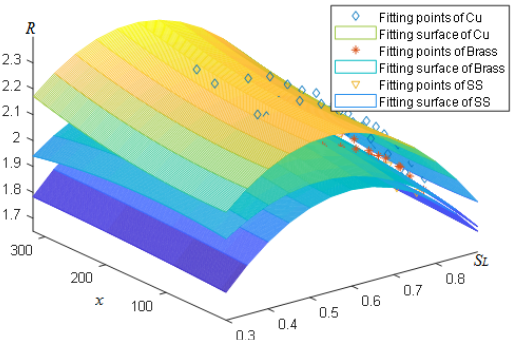
Figure 12. S L - x - R R_value calibration surface of heavy metals Cu, brass and SS. Table 3. R_value calibration surface coefficients.